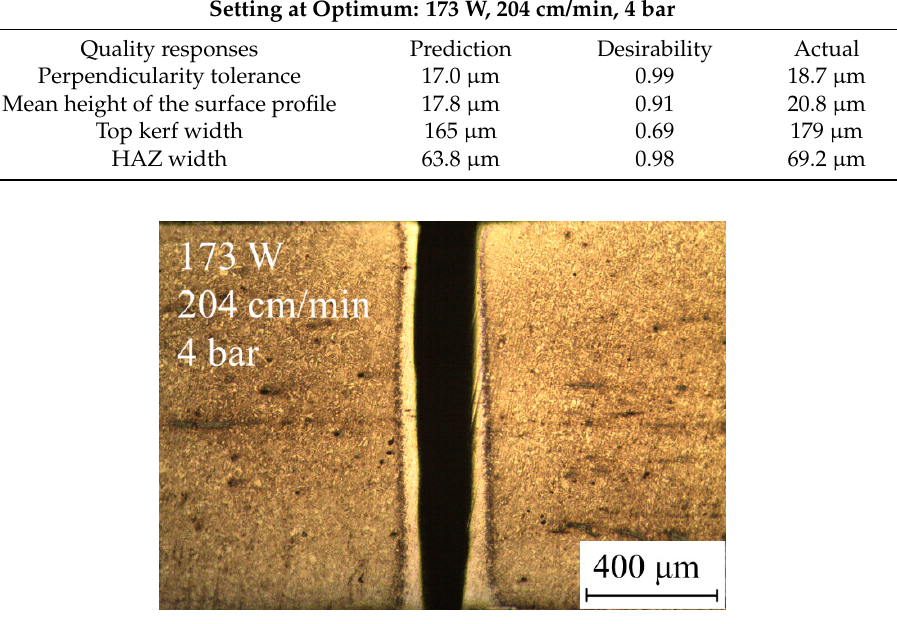
Figure 15. Cross sectional area of the cut surface obtained using the optimal computed operating condition (173 W, 204 cm/min, 4 bar).